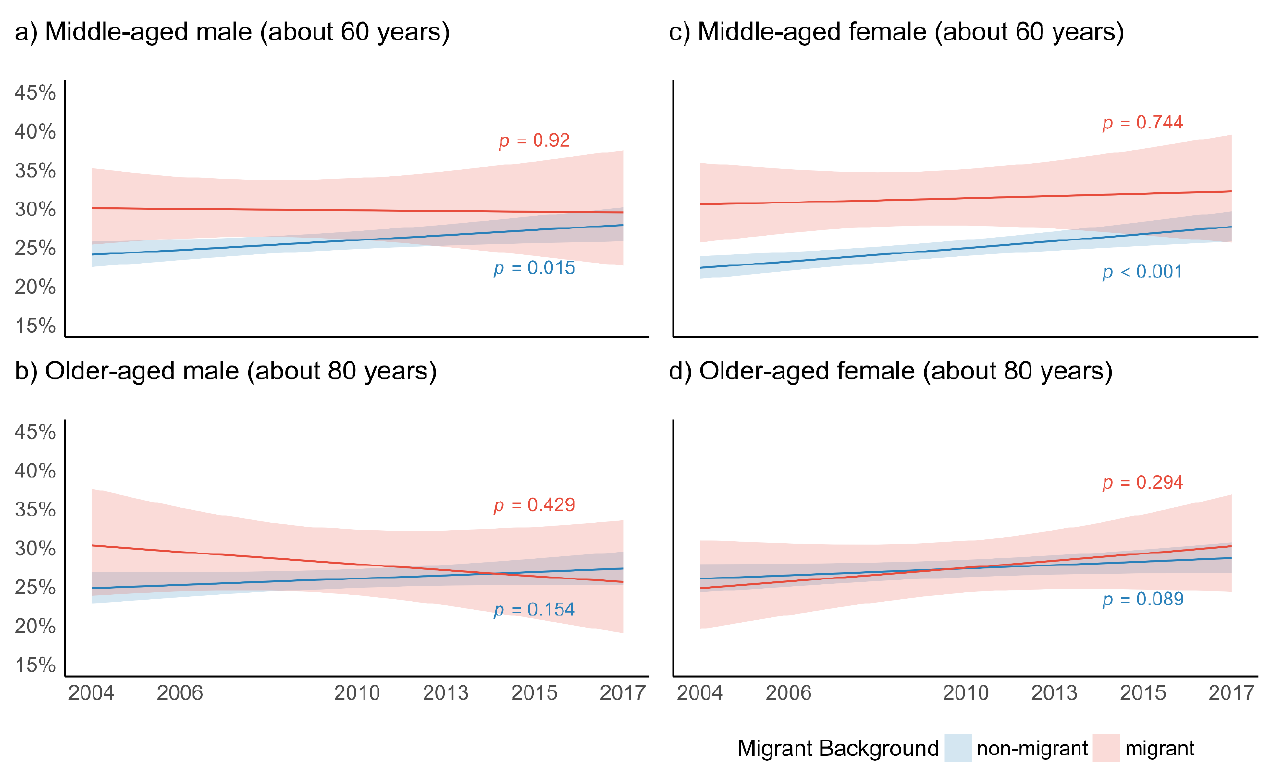
Figure 2. Predicted probabilities of EURO-D (% depressed = four or more symptoms of depression) for migrant background, age and gender (across six waves of SHARE); p -values relate to change over time for migrant and non-migrant elderly.